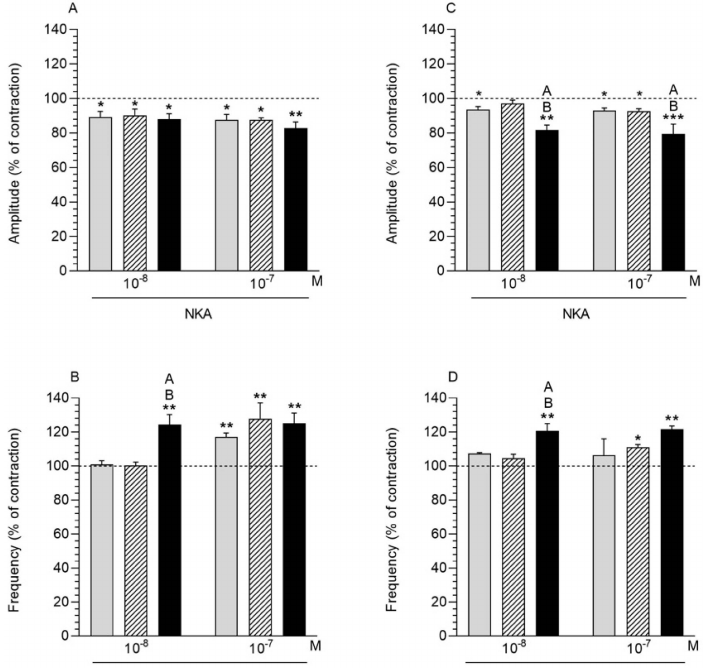
Figure 5. The effect of neurokinin A (NKA) on the contractile amplitude ( A , C ) and frequency ( B , D ) in the myometrium ( A , B ) and endometrium/myometrium ( C , D ) strips of gilts from the CON (grey bars), SAL (hatched bars) and E. coli (black bars) groups. Results were calculated for five gilts in each group. The effects of individual NKA doses are depicted as percentages (mean ± SEM) of the baseline (pretreatment period) contractile amplitude and frequency, taken as 100% (horizontal lines). * p < 0.05, ** p < 0.01, *** p < 0.001, compared to the basal value in each group; A p < 0.05 compared between the CON and E. coli groups for the same treatment; B p < 0.05 compared between the SAL and E. coli groups for the same